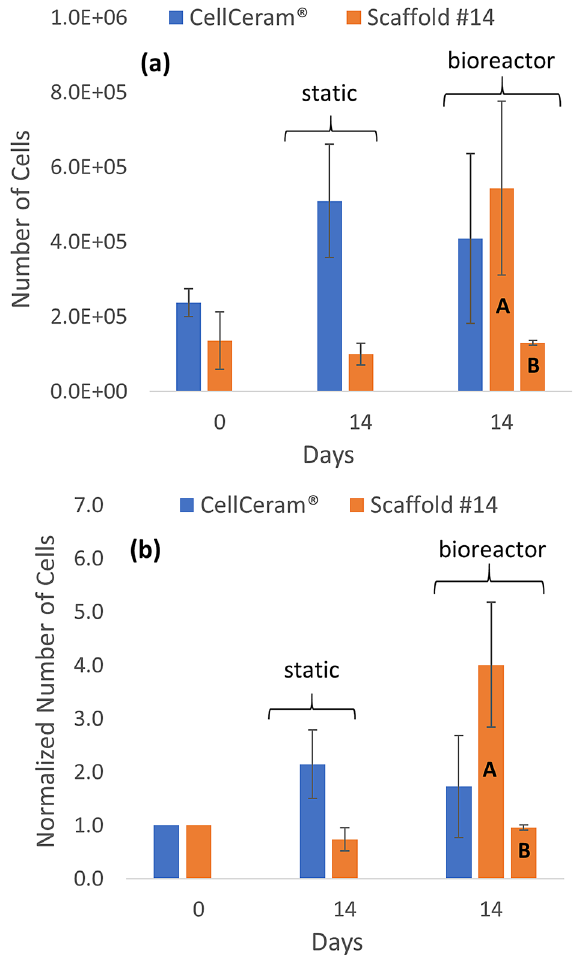
Fig. 8 a Number of cells for the CellCeram ™ scaffold and for scaf- fold #14 on day 0, and after 14 days of cell culture in a tissue-cul- ture dish (static) and inside the bioreactor. For scaffold #14, the results have been presented for two bioreactor chambers (n = 3). b The corresponding number of cells normalized with respect to